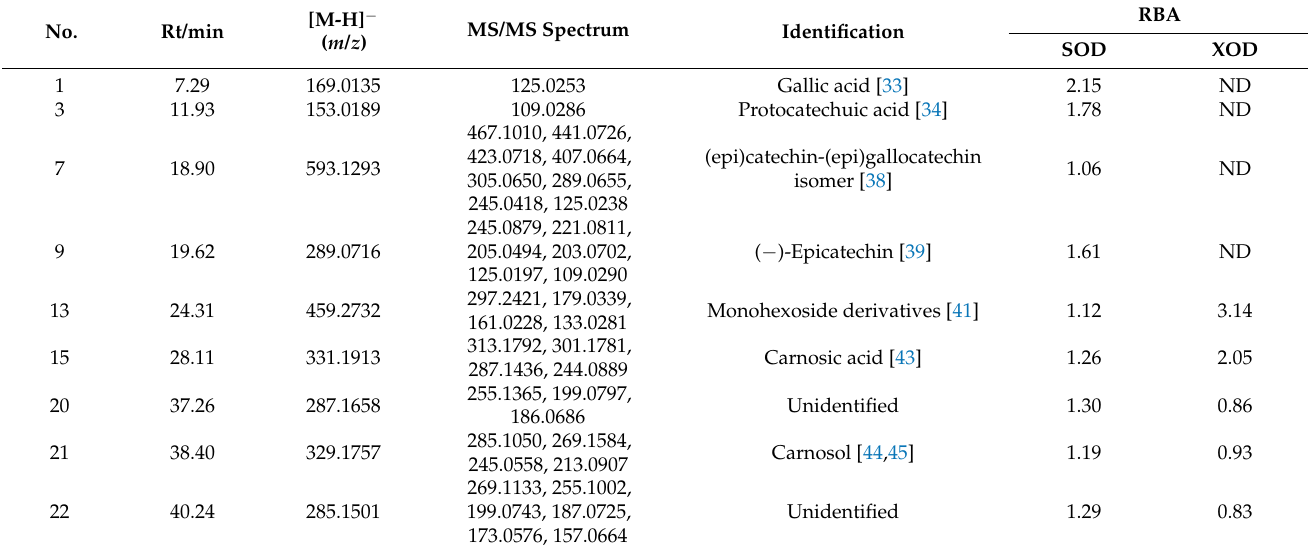
Table 2. The relative binding affinity (RBA) and the UF-LC-MS data of potential SOD and XOD ligands in A. indica